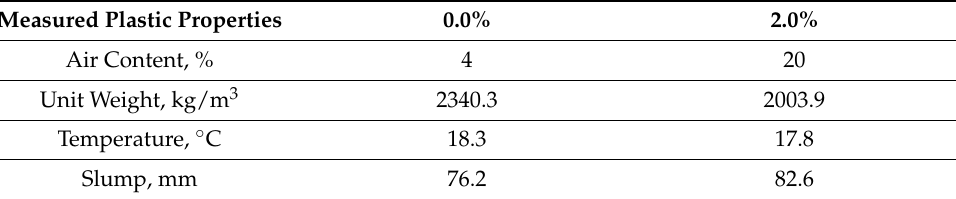
Table 3. Plastic Concrete Properties for Each Concrete Mixture